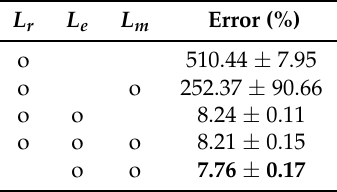
Table 4. GSD prediction errors for cost combination with the log GSD scale dataset 1.